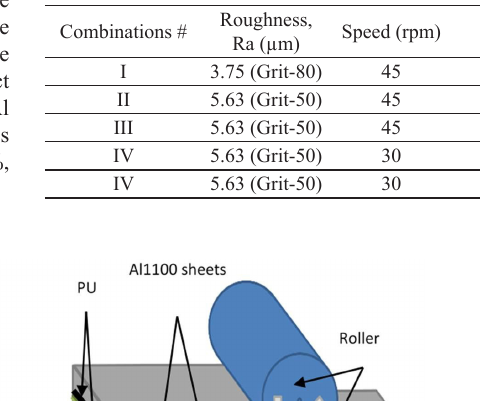
Table 1. The combinations between the different manufacturing